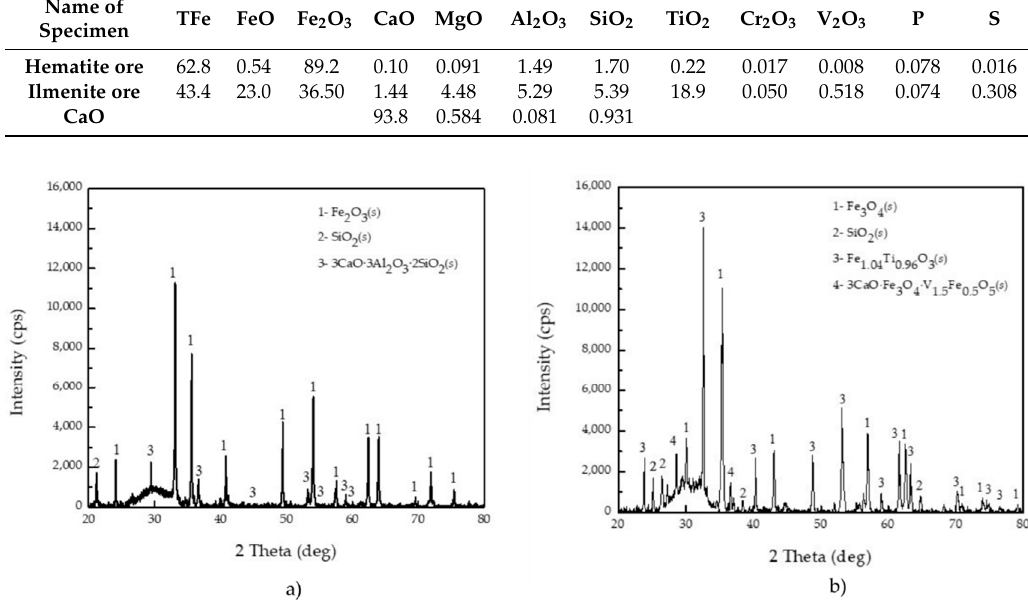
Figure 1. X-ray di ff raction (XRD) results. ( a ) Hematite ore and ( b ) Ilmenite ore. Figure 1. X-ray diffraction (XRD) results. ( a ) Hematite ore and ( b ) Ilmenite ore.